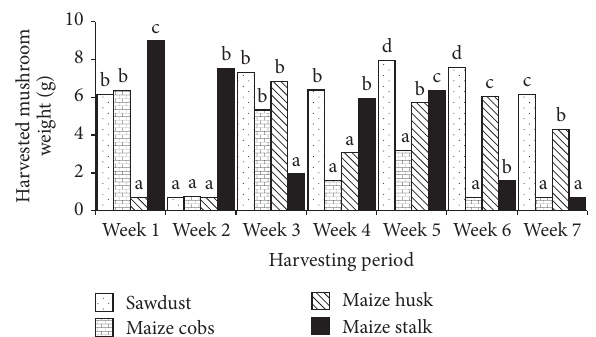
Figure 2: The effect of substrate material on mushroom yield over time. (1) Bars with the same Arabic numerals during a harvesting period are not significantly different 𝑃 < 0.001 . (2) 50g of mushroom spawn was mixed with 1kg substrate and incubated at 26–28 ∘ C for about 20–34 days. (3) The mushroom yield was recorded over six weeks.